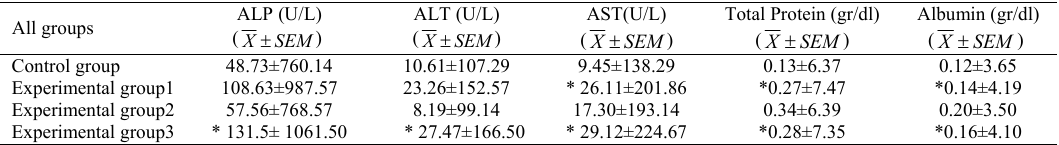
Table 1: Comparison of mean concentrations of ALP, AST, ALT, albumin and total protein between the experimental groups receiving silver nanoparticles and the control group.